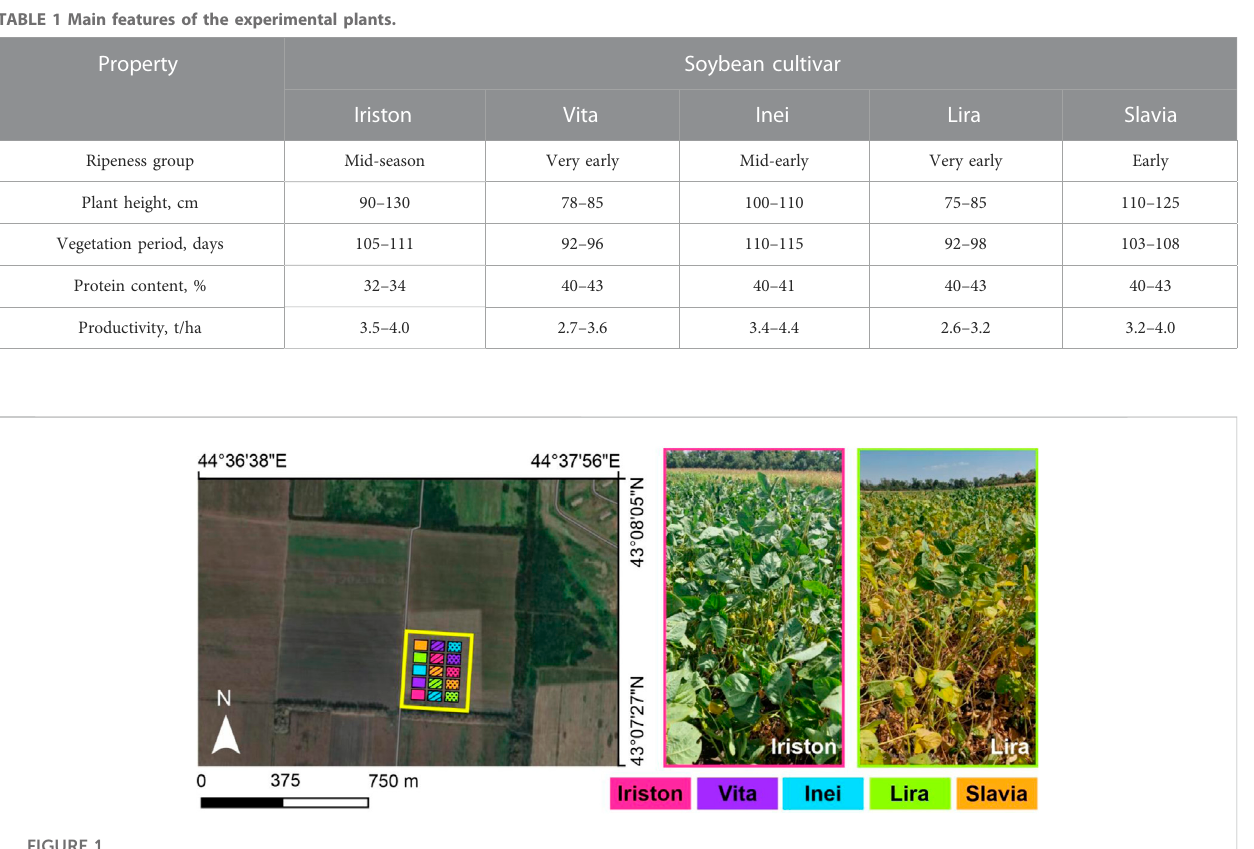
FIGURE 1 Image of the experimental fi eld (left) with the region involved in the study (yellow rectangle). Colors of 15 plots correspond to fi ve selected soybean cultivars. Three types of plot hatching designate the duplicate number. Right part of the fi gure illustrates the images of two plots with Iriston and Lira soybean